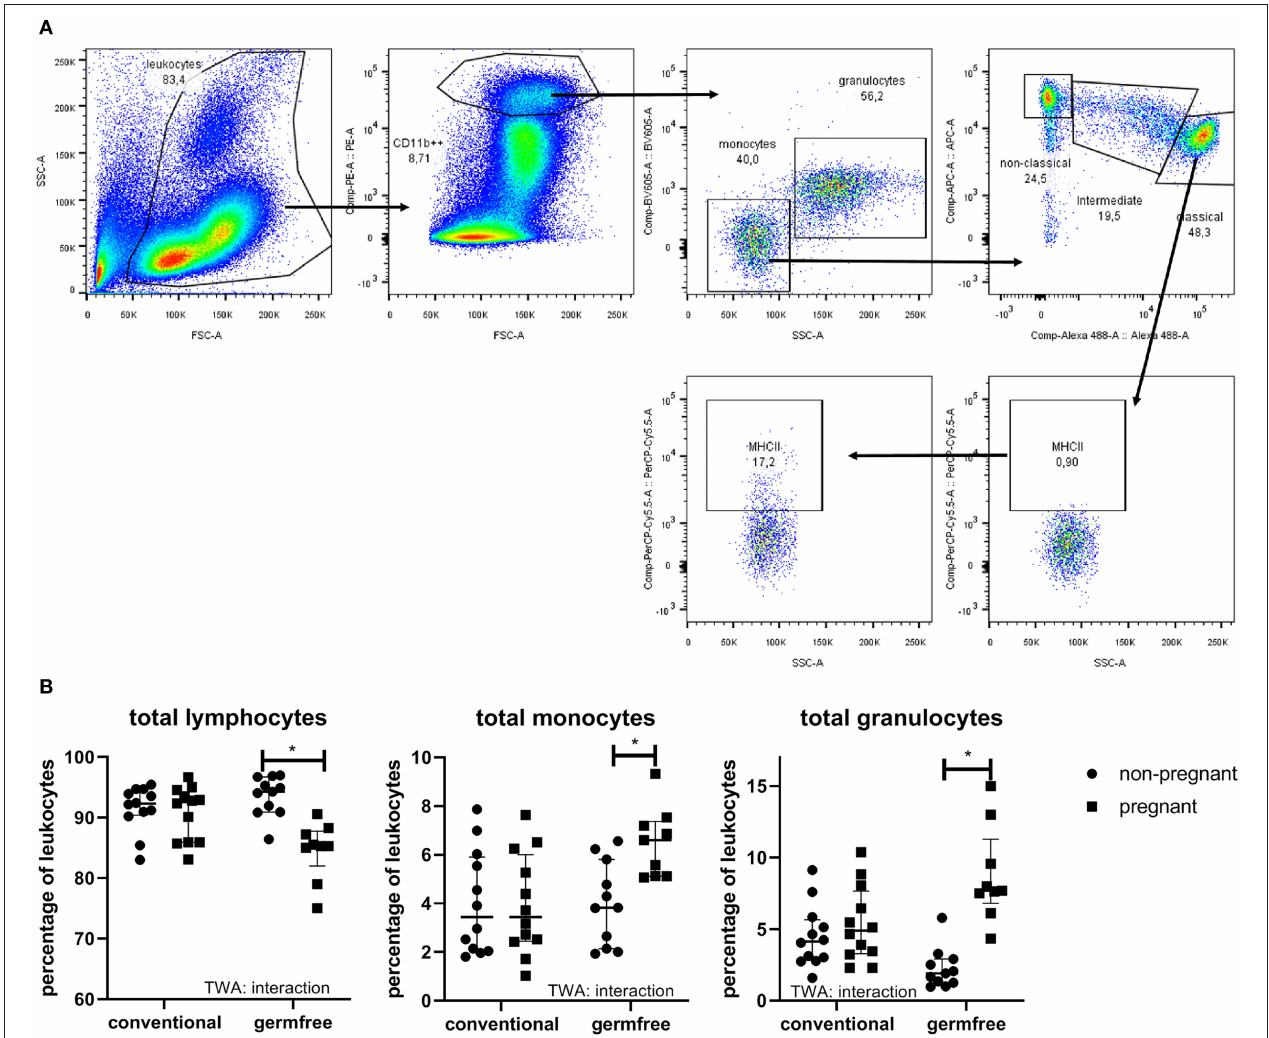
FIGURE 7 | (A) Gating strategy for leukocyte populations and monocytes. In the FSC-SSC plot, we selected the leukocytes, which were copied to the FSC-PE plot to select CD11b ++ cells (myeloid cells). These myeloid cells were copied to an SSC-BV605 plot to discriminate monocytes from granulocytes. Percentages of monocytes and granulocytes were derived from this plot. Percentage lymphocytes was 100% of myeloid cells. The monocytes were then copied to an Alexa488-APC plot to discriminate classical, intermediate and non-classical monocytes. Each of these three subsets were then copied to an SSC-PerCPCy5.5, to select MHCII + cells (example is shown for classical monocytes), using the FMO to set the gates. Each of these monocytes’ subsets were also copied to an SSC-Pacific Blue plot to select the CD80 + cells, using FMO to set the gates, similar to MHCII (not shown in the figure). (B) Percentage of lymphocytes, monocytes, and granulocytes in whole blood of pregnant (day 18) and non-pregnant conventional and germfree mice. TWA, Two-way ANOVA. *Significantly different from non-pregnant mice (TWA followed by Fisher’s LSD post-test, p < 0.05).